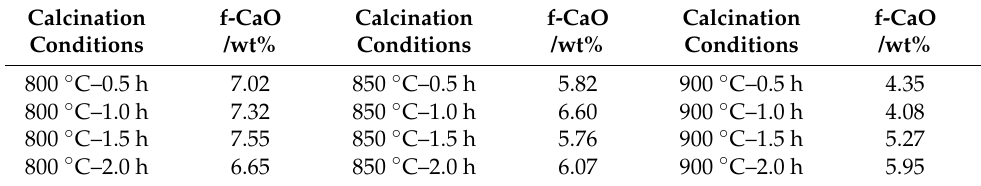
Table 6. Content of calcined sample